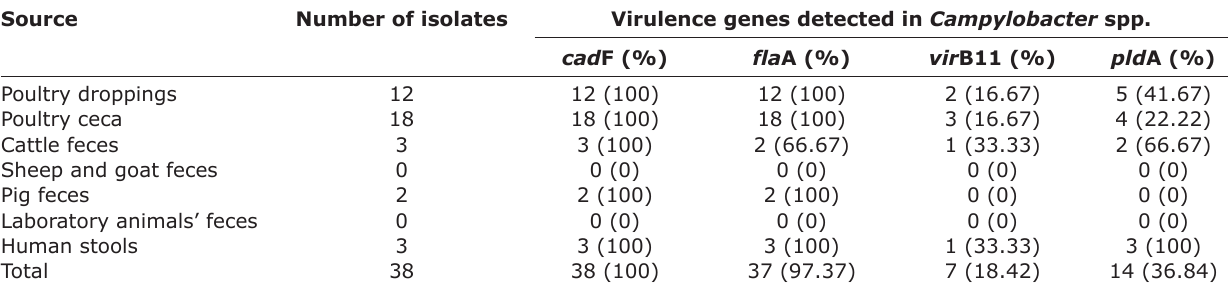
Table-2: Prevalence of virulent genes in Campylobacter isolates recovered from various sources. Source